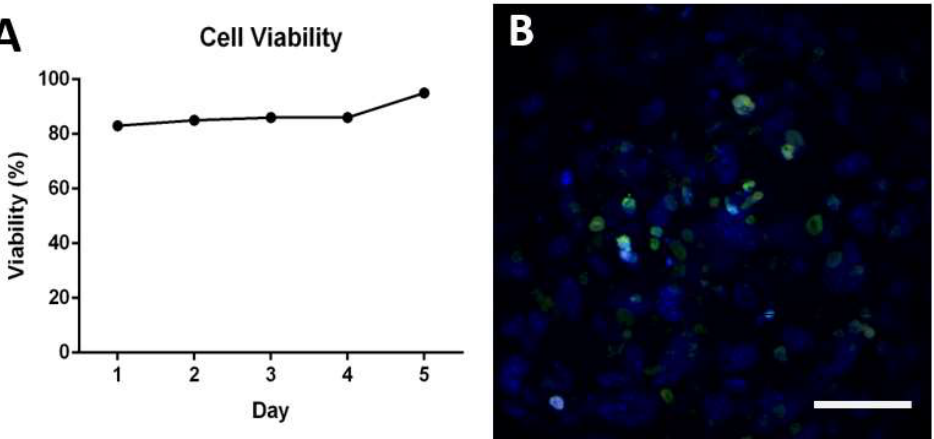
Figure 2. ( A ) Percentage of viable cells among the total cells measured by the Trypan Blue exclusion test during the first 5 days of aggregate formation. ( B ) Confocal microscopy imaging of the central section of a 20,000-cell aggregate, labeled for viable cell DNA through Hoechst 33342 (blue) and for caspases3/7 (green) indicating apoptosis. The scale bar indicates 50 µm.